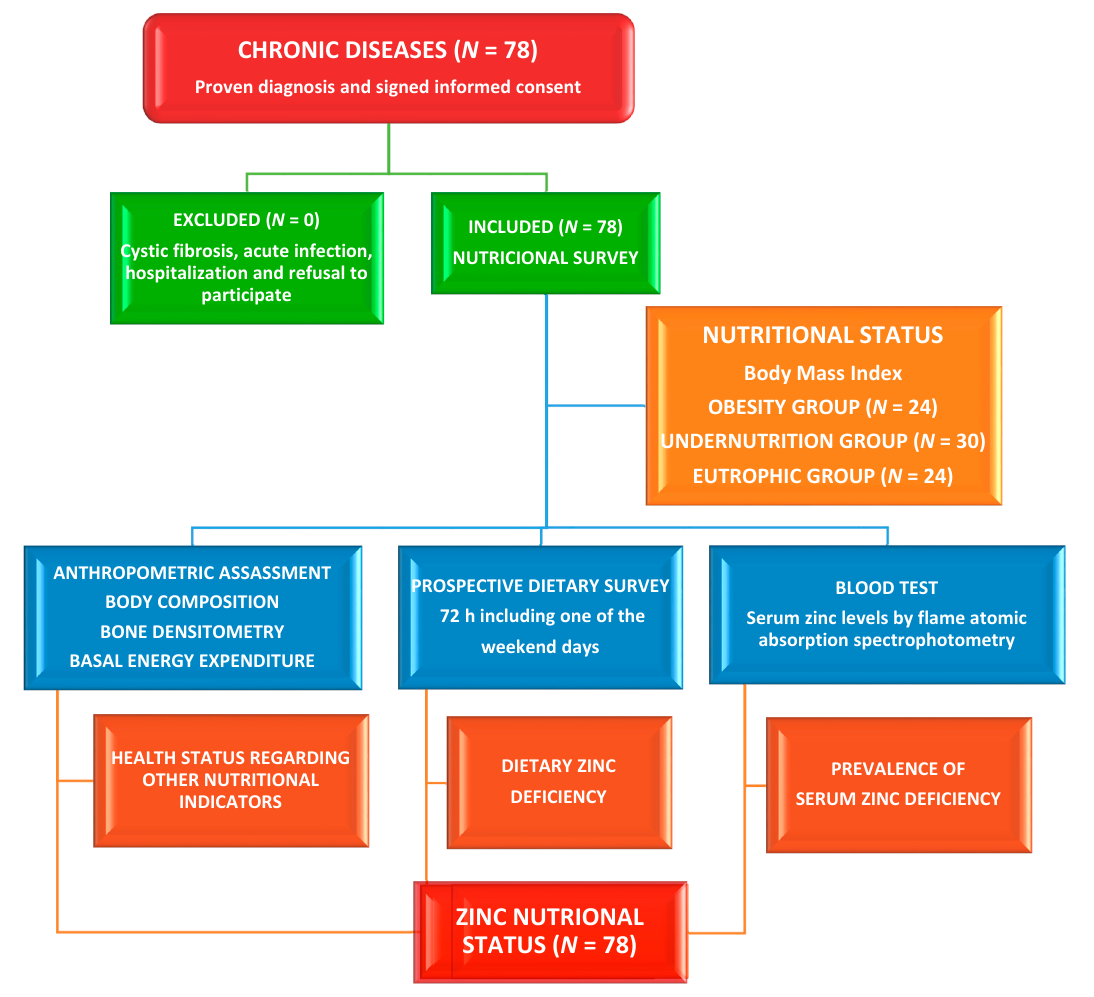
Figure 1. Flow diagram assignment of patients with chronic diseases ( N = 78).